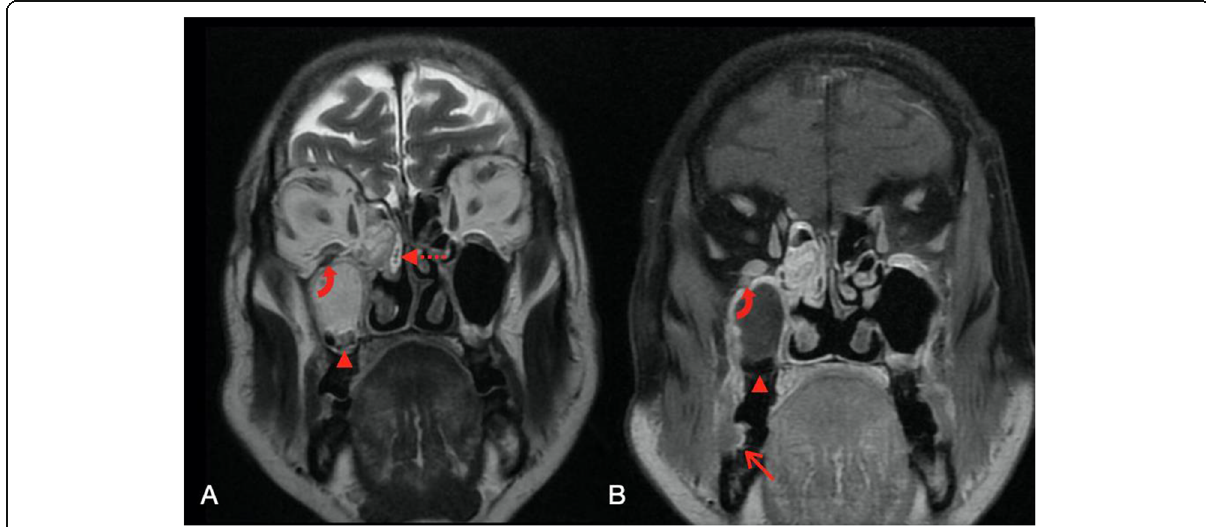
Fig. 6 Coronal T2 ( A ) and T1 FS +Contrast ( B ) demonstrating the enhancing mucosal thickening in right ethmoidal and bilateral maxillary sinuses with non-enhancing collection in right maxillary sinus (arrowhead). Enhancing soft tissue extension is noted in right orbit abutting inferior rectus muscle (curved arrow) and extending into right nasolacrimal duct (dashed arrow). Laterally, it is extending to involve right buccinator muscle (thin